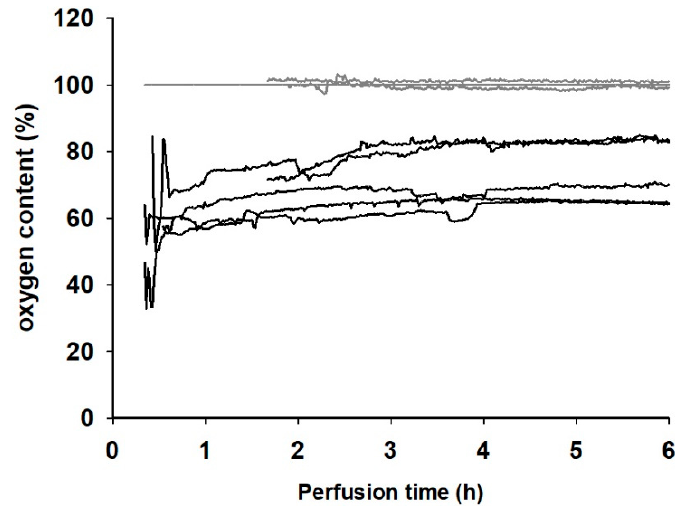
Figure 2. Oxygen content in % of the saturation concentration of the arterial (gray lines) and venous (black lines) perfusate.